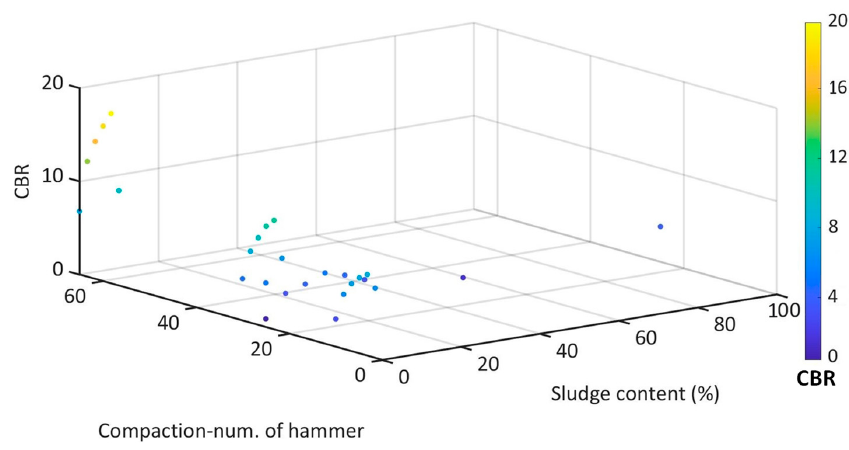
Figure 4. Database used for modeling based on the CBR.